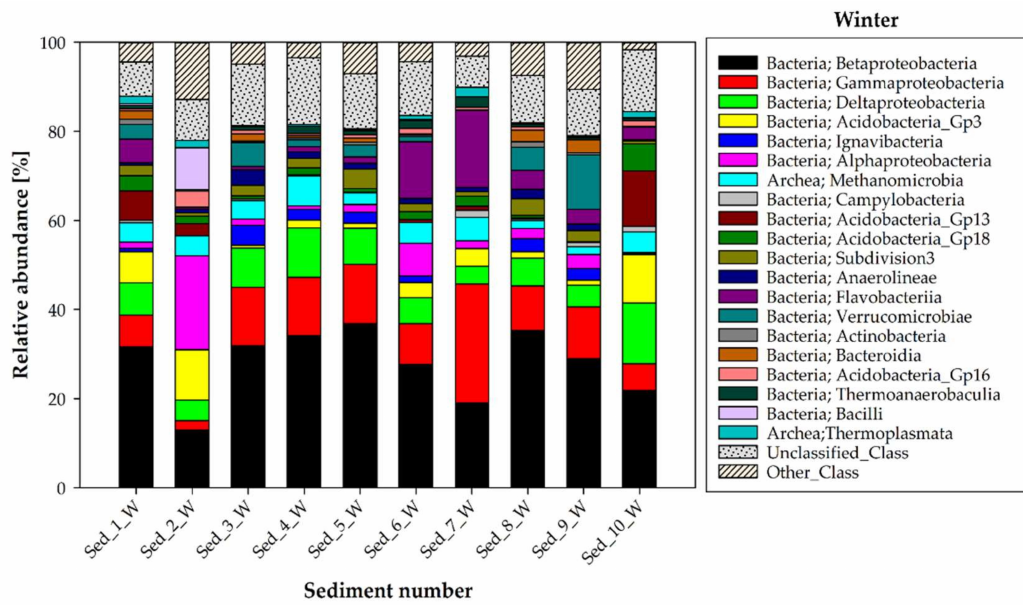
Figure 4. Seasonal changes in the classes of bacteria in the selected locations of bottom sediment sam- pling in Cardinal Pond (1–10 Sed—sediment sampling points; Sp—spring, Su—summer, A—autumn,